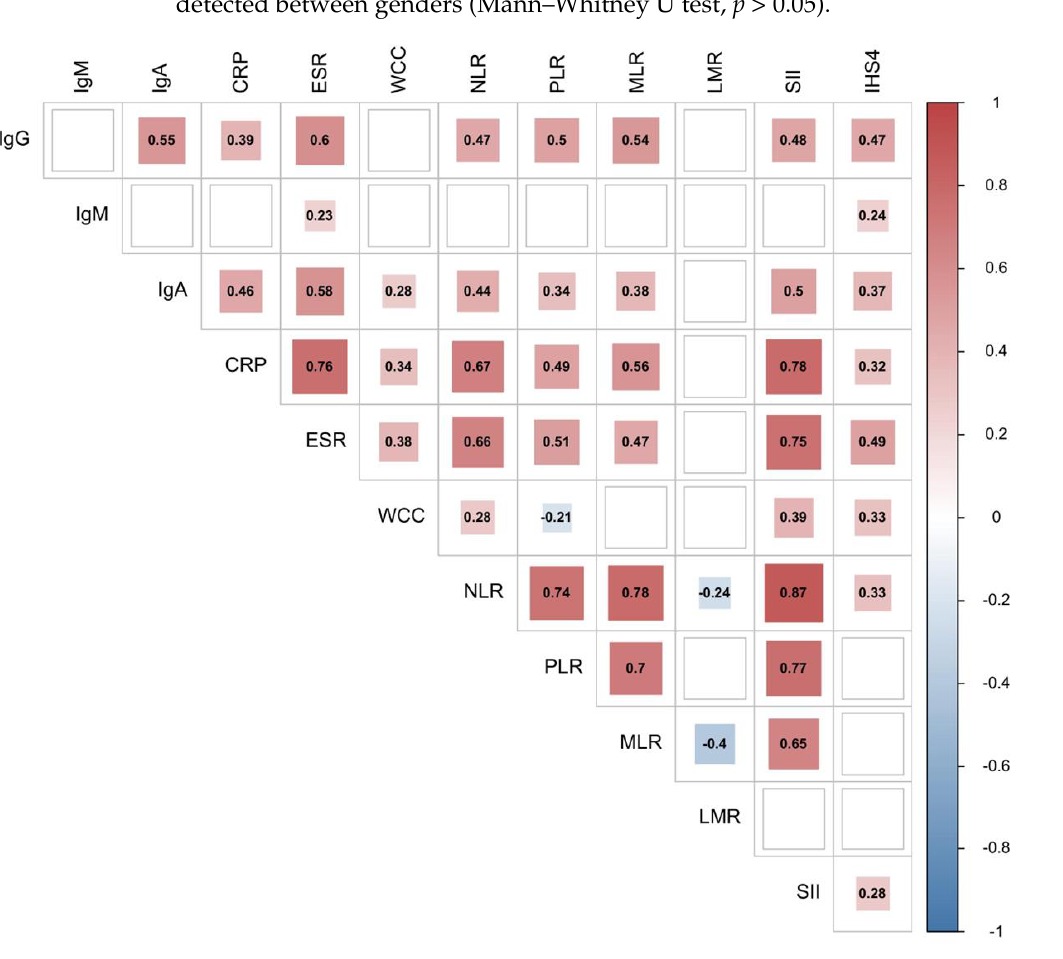
Figure 1. Correlation matrix between immunoglobulin levels, haematological indices of inflammation and disease severity according to IHS4 classification. The square colour depicts Spearman’s rank-order correlation coefficient, with its size and colour intensity indicating the magnitude of the correlation coefficient. Significant correlation coefficients are labelled. Empty cells represent insignificant pairwise correlation between indices. SII - systemic immune-inflammation index.